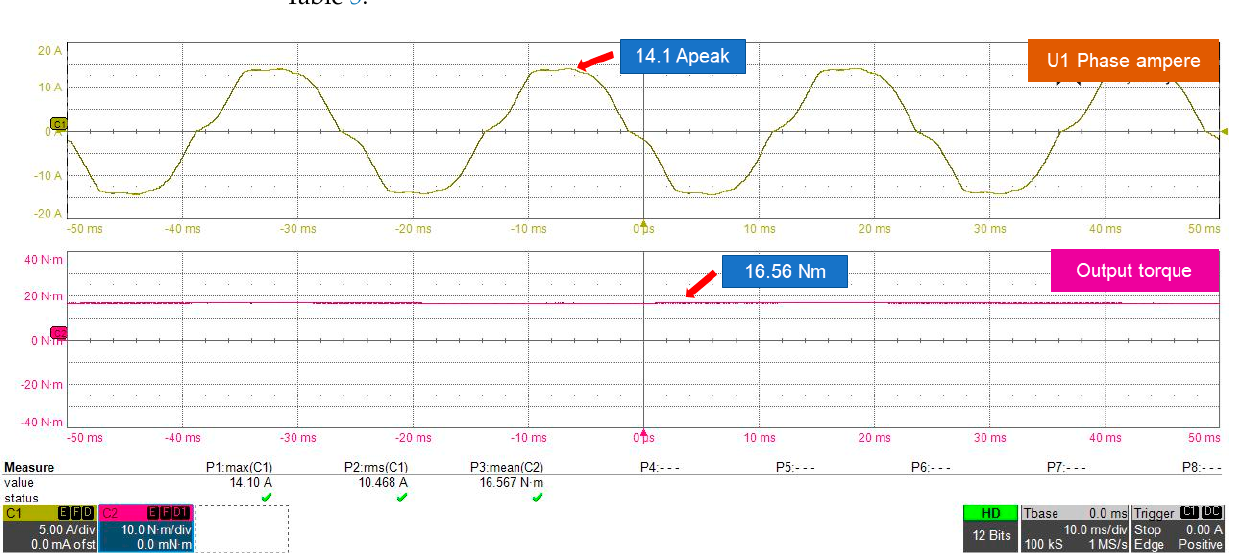
Figure 17. Torque curves at 480 r/min and 10 Arms for fifth-harmonic injection-controlled operation.